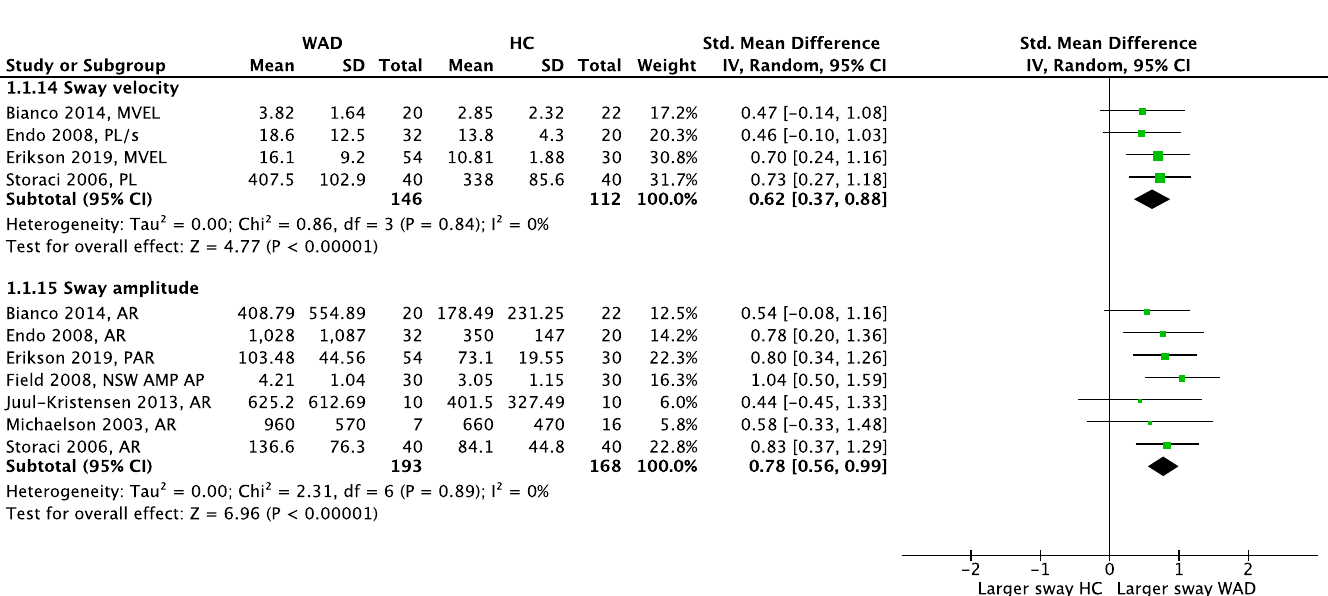
Fig 5. Forest plot demonstrating meta-analysis of sway velocity and sway amplitude (eyes open) in people with WAD vs. HC. WAD: whiplash-associated disorder; HC: healthy control; SD: standard deviation; IV: inverse variance; CI: confidence interval; Std: standardized; MVEL: mean velocity (mm/s); PL: path length (mm); AR: area (mm 2 ); PAR: perimeter of sway area (mm); AMP: amplitude (mm); AP: anteroposterior; NSW: narrow stance width.